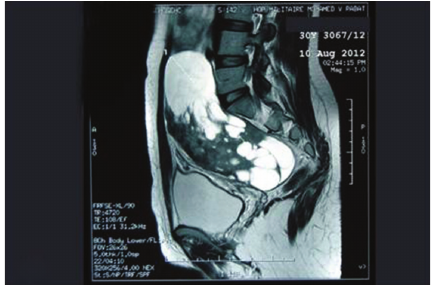
Figure 2: Pelvic MRI: Sagittal T2-weighted image, showing an intraperitoneal tumor with tissular and cystic signal. The tumor is separated from the uterus. The cystic areas appear hyperintense on T2-WI. And the tissular parts present heterogeneous signal on T2 sequence with hypointense areas corresponding to fibrotic tissue. The solid component of the tumor enhances strongly and heterogeneously after gadolinium injection.